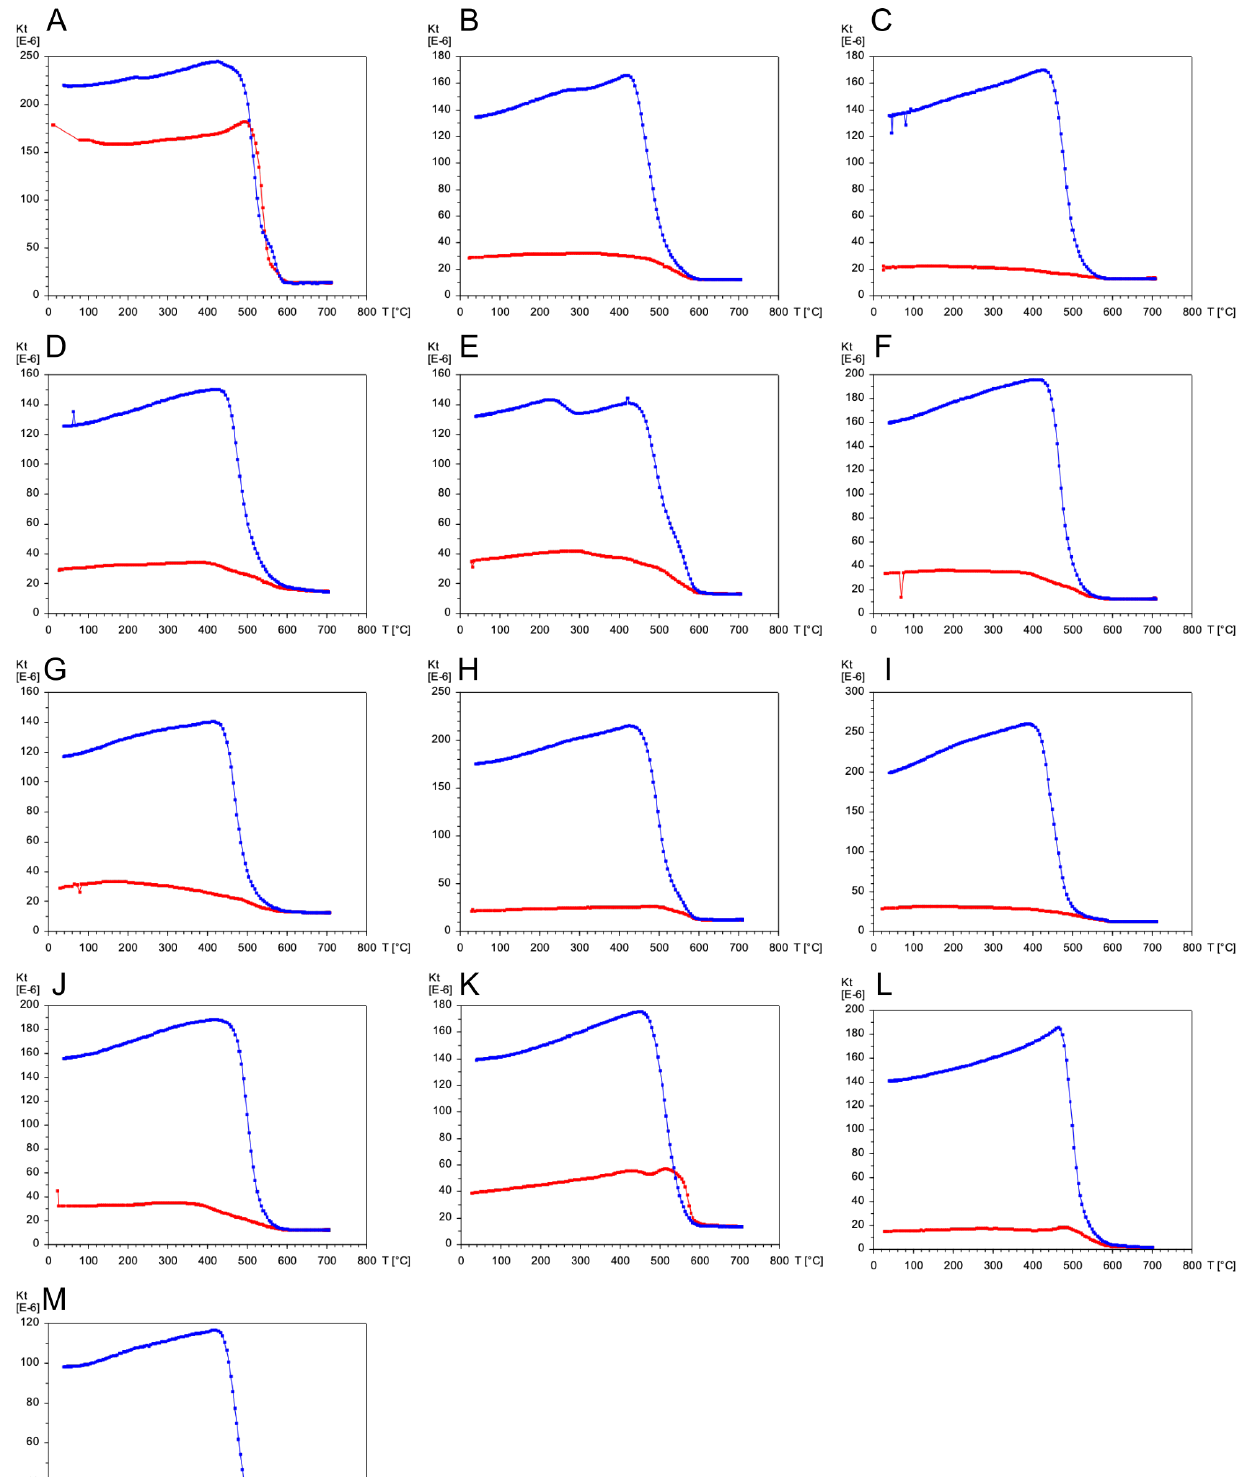
Figure A4: Curie Point Estimate Heating-Cooling Diagrams for [A] PDD - 1C; [B] PDD - 2B; [C] PDD - 3F; [D] PDD - 4B; [E] PDD - 5K; [F] PDD - 6H; [G] PDD - 7L; [H] PDD - 8A; [I] PDD - 9E [J] PDD - 10J; [K] PDD - 11P; [L] PDD - 12G; [M] PDD -